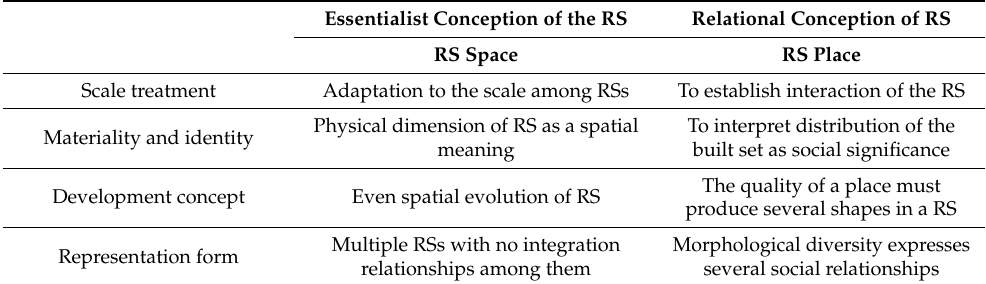
Table 1. Space and place contexts for delimitation of a RS. Source: Adapted from Healey [81] and Yang [82].